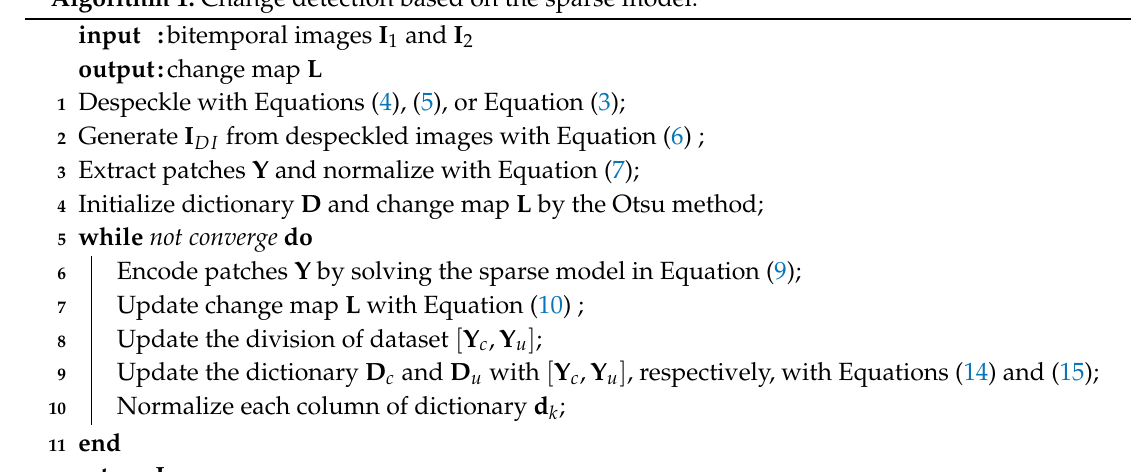
Algorithm 1: Change detection based on the sparse